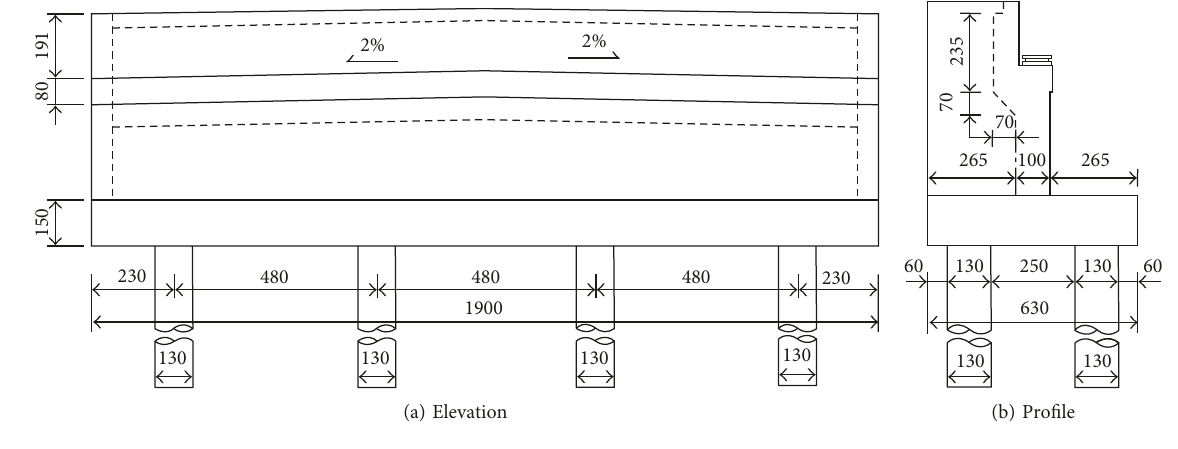
Figure 1: Abutment structure (cm). Table 1: Mix proportion of abutment concrete.